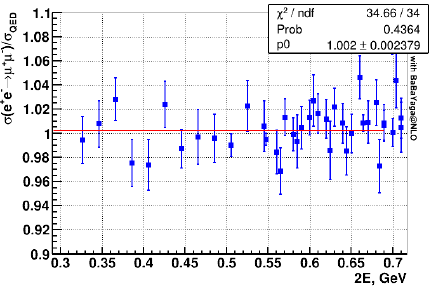
Figure 6. Ratio of the measured 2 π cross-section to the common fit | F π | 2 parametrization. Blue points - season 2013, red points -